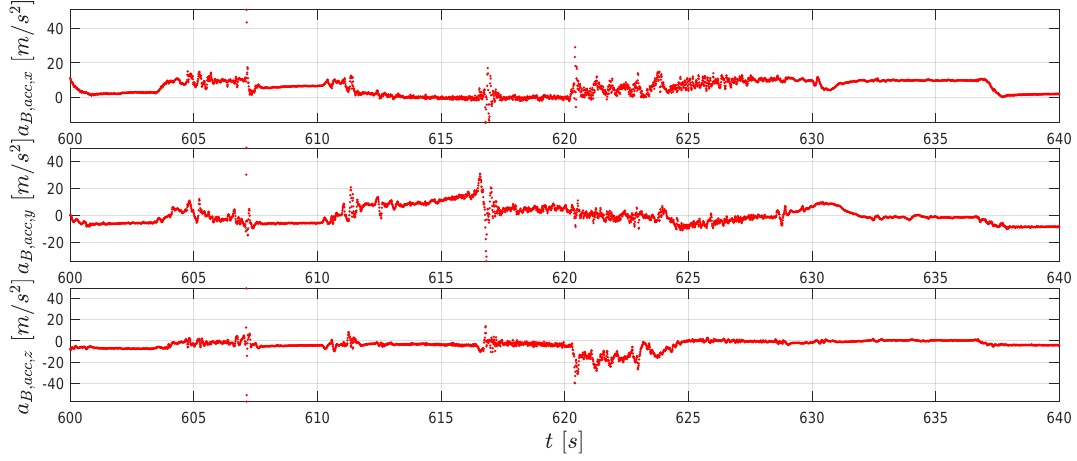
Figure 14. The accelerometer measurements a B, acc (red dots) .